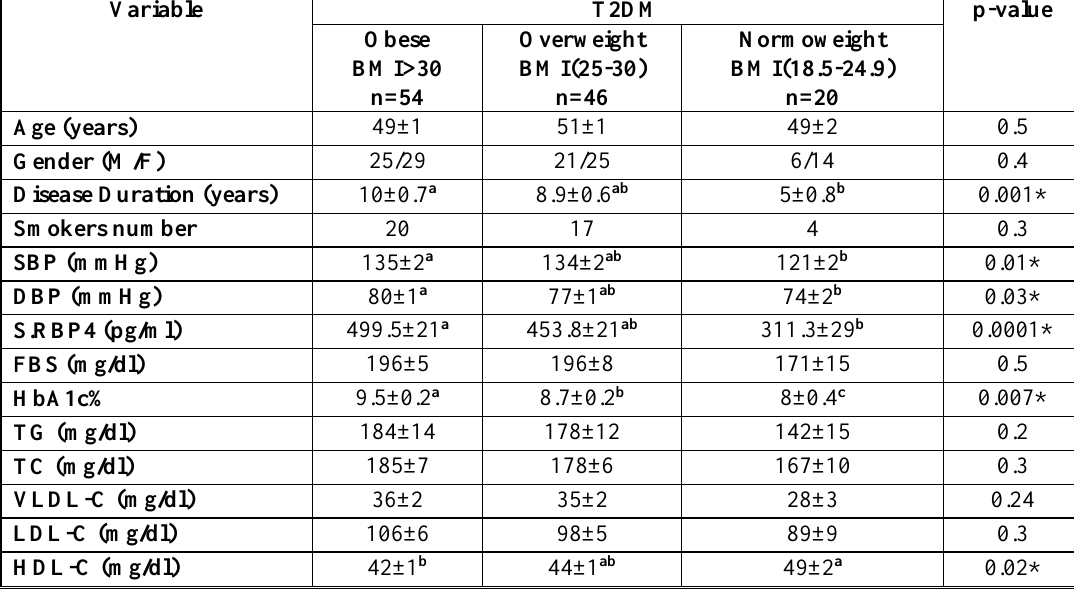
Table-3. Characteristics of obese, overweight, and normoweight T2DM patients